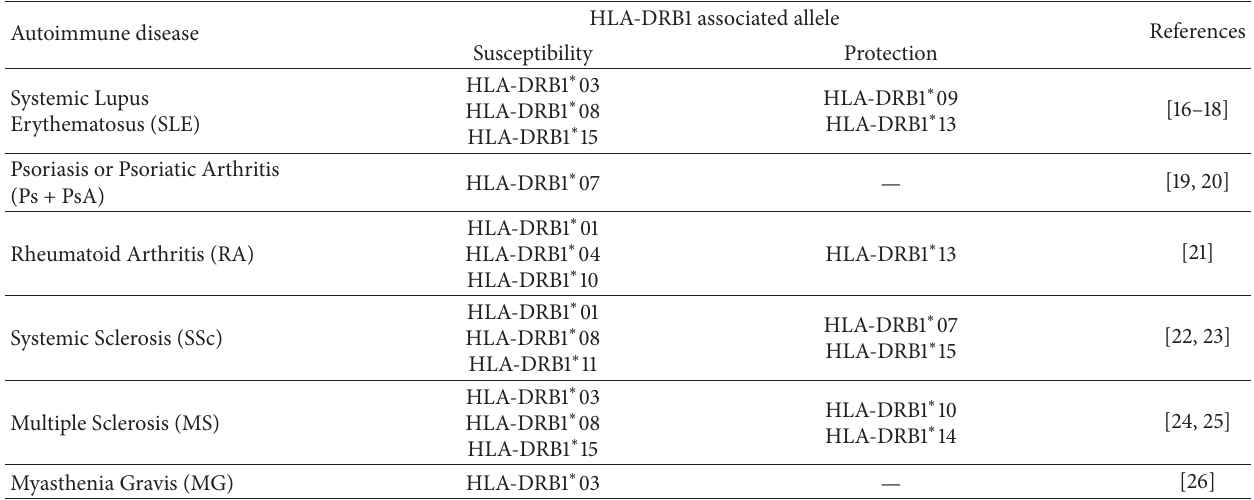
Table 1: HLA-DRB1 alleles associated with SLE, Ps + PsA, RA, SSc, MS, and MG.